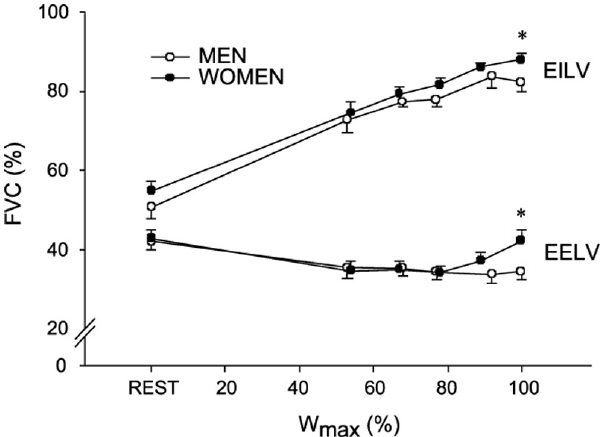
Figure 2. Reprinted with permission from ref. [41]. 2007 Blackwell Publishing. Regulation of lung volumes in men and women during progressive exercise to exhaustion. The end-expiratory (EELV) and end-inspiratory (EILV) lung volumes are expressed as a % of forced vital capacity (FVC). Higher EILV and EELVs were seen in women during progressive exercise, indicating dynamic hyperinflation. * Significantly different from men ( p < 0.05)